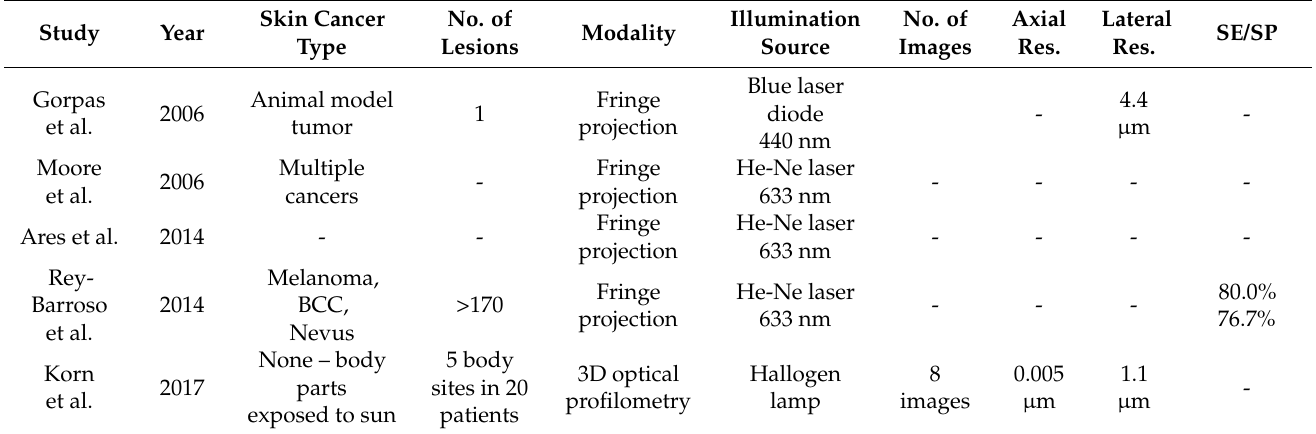
Table 3. Contributions of 3D topography to skin cancer